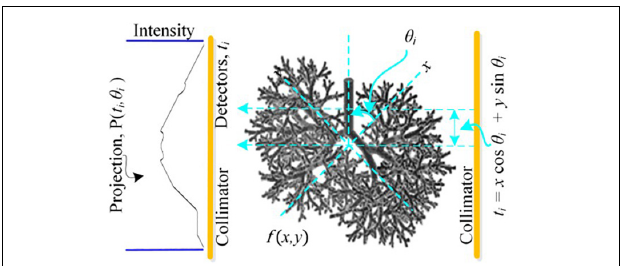
FIGURE 1 | Model depicting forward projection at an orthogonal distance t through the center of a hypothetical cross-section f ( x , y ) of lung rotated by θ in Cartesian coordinates ( x , y ) .